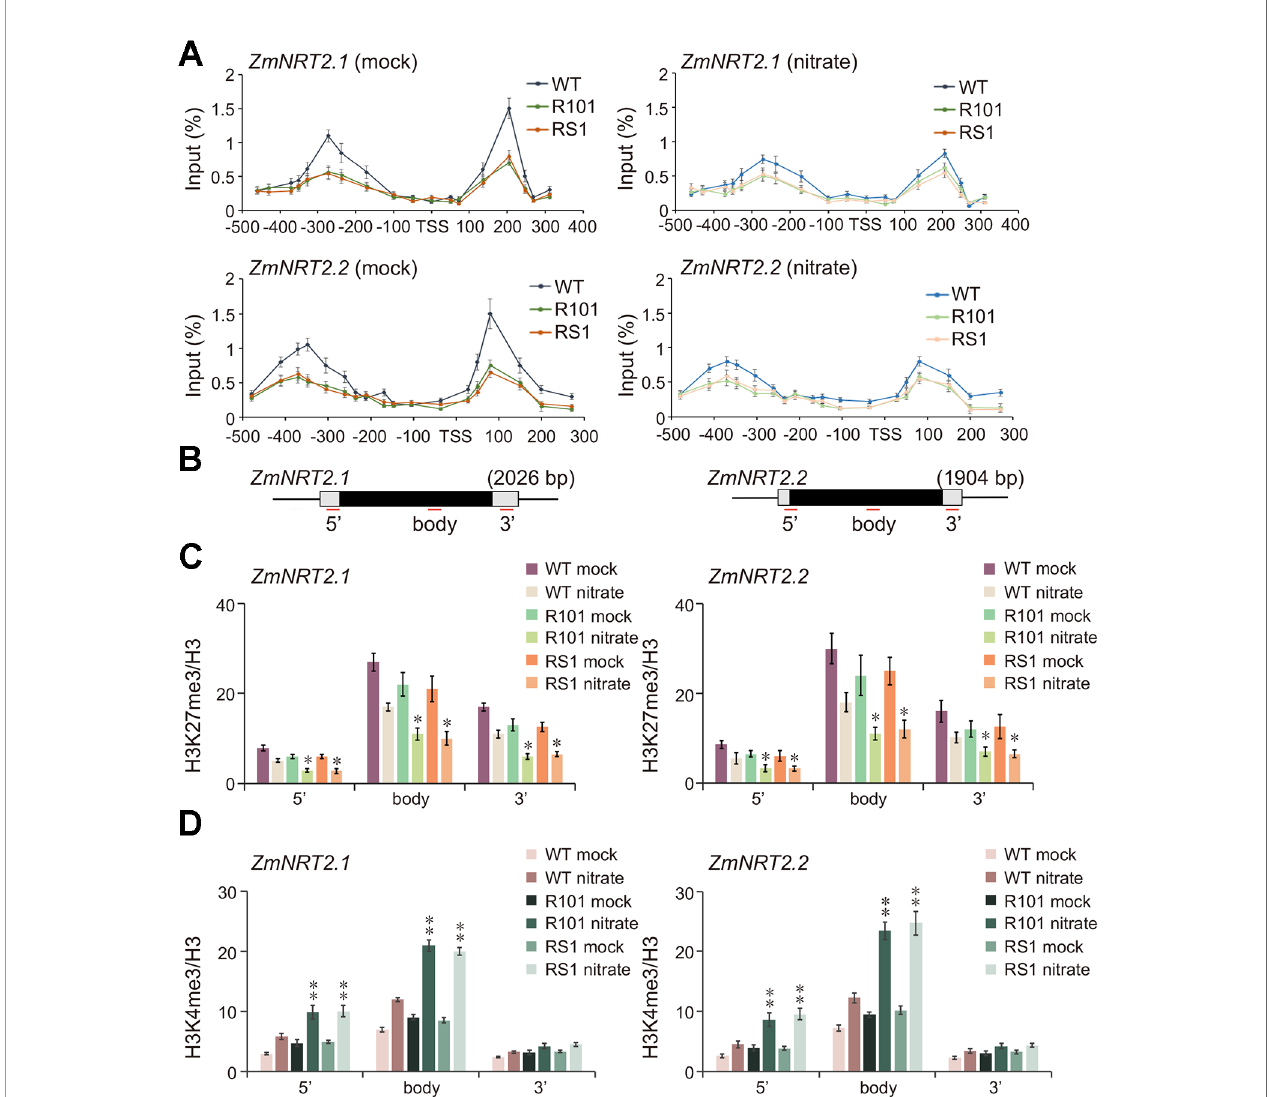
FIGURE 4 | ZmCHB101 affects nucleosome occupancy and histone modi fi cation status of ZmNRT2.1 and ZmNRT2.2 . 7-day-old nitrate-free seedlings under the mock and nitrate condition were used for chromatin immunoprecipitation and quantitative PCR (ChIP-qPCR) assay. (A) ChIP-qPCR using anti-H3 antibody was performed to dissect nucleosome occupancies and densities at -1 and +1 nucleosomes in ZmNRT2.1 and ZmNRT2.2 promoters. The X-axis denotes distance from TSS. The Y-axis denotes nucleosome occupancy normalized relative to the input DNA. (B) Schematic diagram of ZmNRT2.1 and ZmNRT2.2 . The untranslated regions are shown as open boxes and the exons as black boxes. 5', 5' untranslated region; body, gene body region; 3', 3' untranslated region. (C) H3K27me3 levels at ZmNRT2.1 and ZmNRT2.2 . (D) H3K4me3 levels at ZmNRT2.1 and ZmNRT2.2. The Y-axes in (C , D) denote relative enrichment normalized to the H3. Data represent mean ± SD of the biological replicates ( n = 3). Mock, nitrate treatment for 0 h; nitrate, nitrate treatment for 2 h. Asterisks indicate signi fi cant differences between WT and RS1 or R101 (*, p < 0.05; **, p < 0.01; Student's t